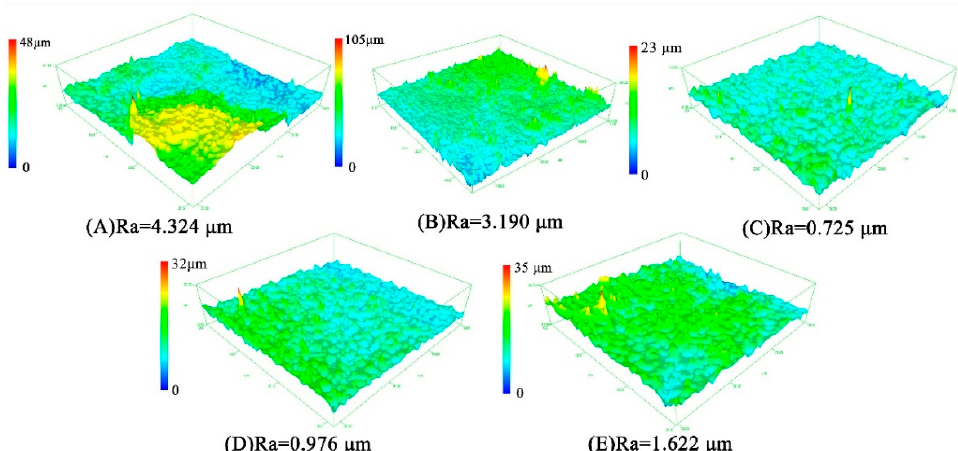
Figure 5. Average surface roughness (Ra) and 3D profilometry of HA coating on PVA/PLA braids with deposition time of ( A ) 60, ( B ) 75, ( C ) 90, ( D ) 105, and ( E ) 120 min.